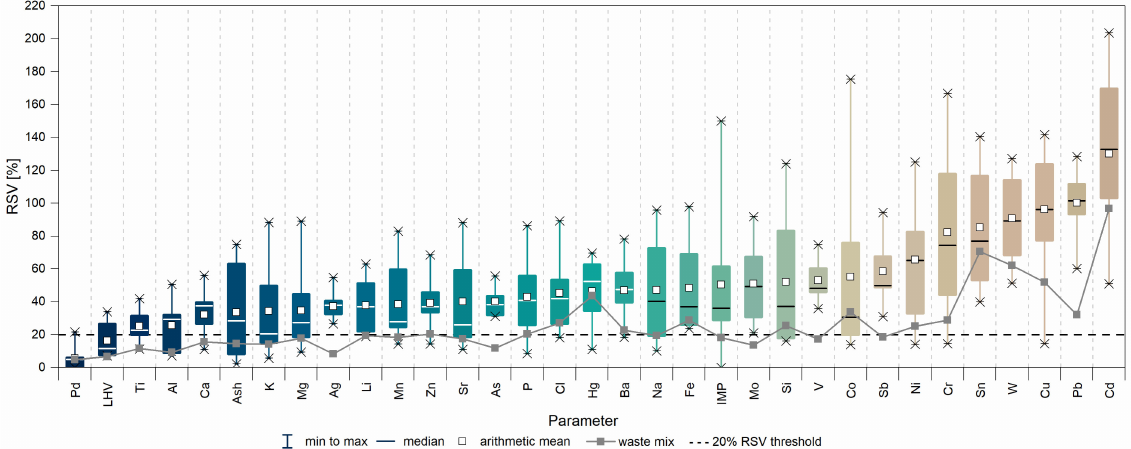
Figure 5. Relative sampling variabilities (RSV) for different elements, lower heating value (LHV), ash content, and hard impurities (IMP) in different particle size classes. The solid grey line represents RSVs calculated for the whole waste mix, i.e., for the united particle size fractions